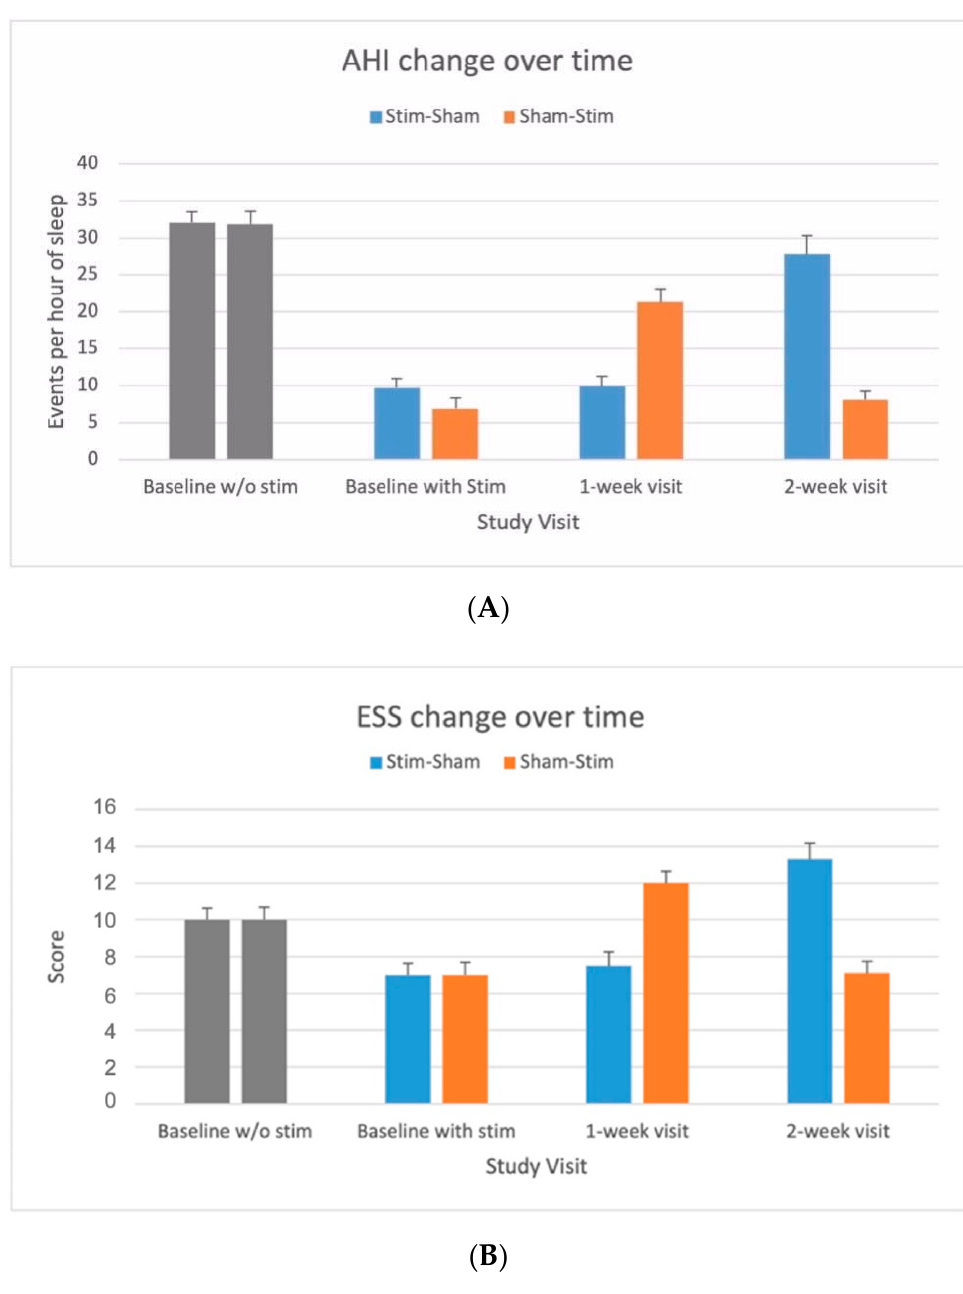
Figure 2. ( A ) OSA severity measured by apnea–hypopnea index (AHI) in response to upper airway stimulation versus sham. AHI values (mean and standard error bar) without stimulation before implantation and with stimulation at baseline, 1-week and 2-week visits for stim–sham and sham–stim groups. AHI values <15 events per hour of sleep considered as free of moderate-to-severe OSA [22]. ( B ). Subjective sleep propensity by Epworth Sleepiness Scale (ESS) in response to upper airway stimulation versus sham. ESS values <10 considered as free of excessive of daytime sleepiness [23].